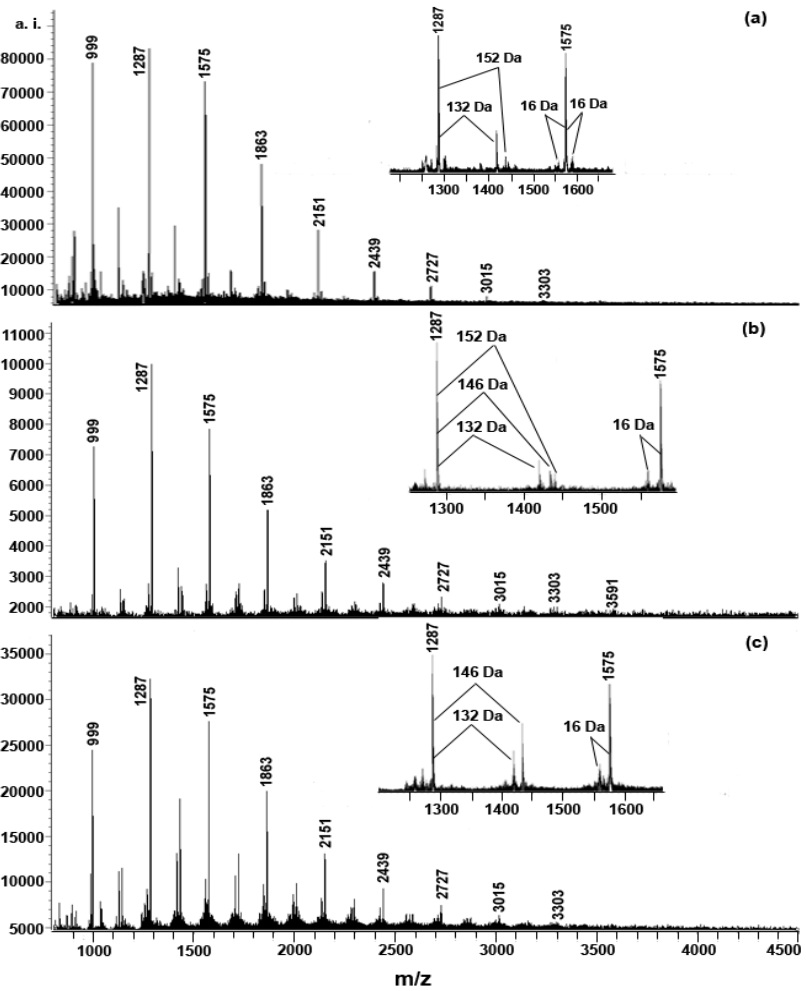
Figure 2. MALDI-TOF positive reflectron mode mass spectra of the condensed tannins from different parts of A. confusa : (a) leaf, (b) stem bark, (c) root